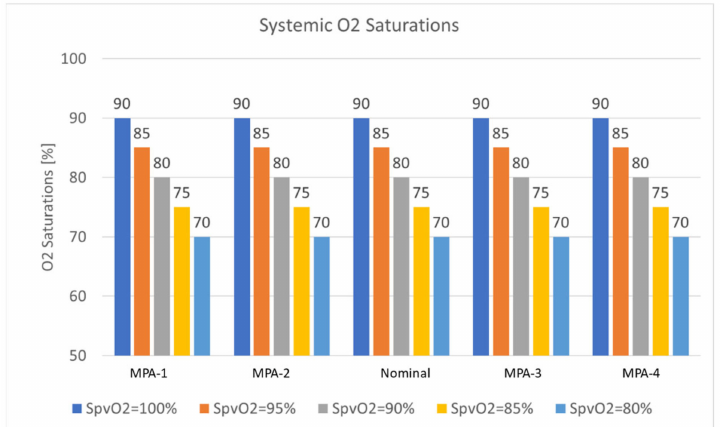
Figure 32. Systemic saturation with different pulmonary venous saturation as a function of the MPA narrowing. Table 17. Total Systemic Flow Rate [L/min] as a function of H and the flow rates at each